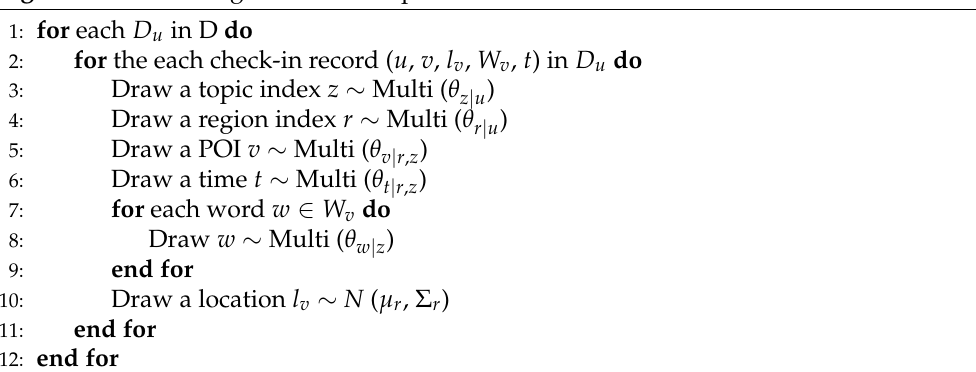
Algorithm 1 Modeling user decision